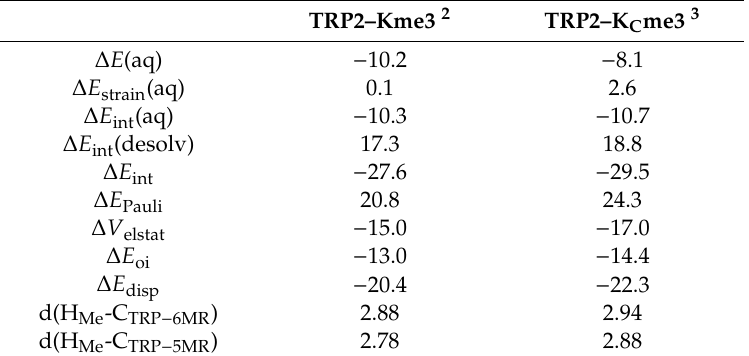
Table 2. Quantum-chemical bonding analysis (energies in kcal mol − 1 , distances in Å) in TRP2–Kme3 and TRP2–K C me3 systems in aqueous solution.